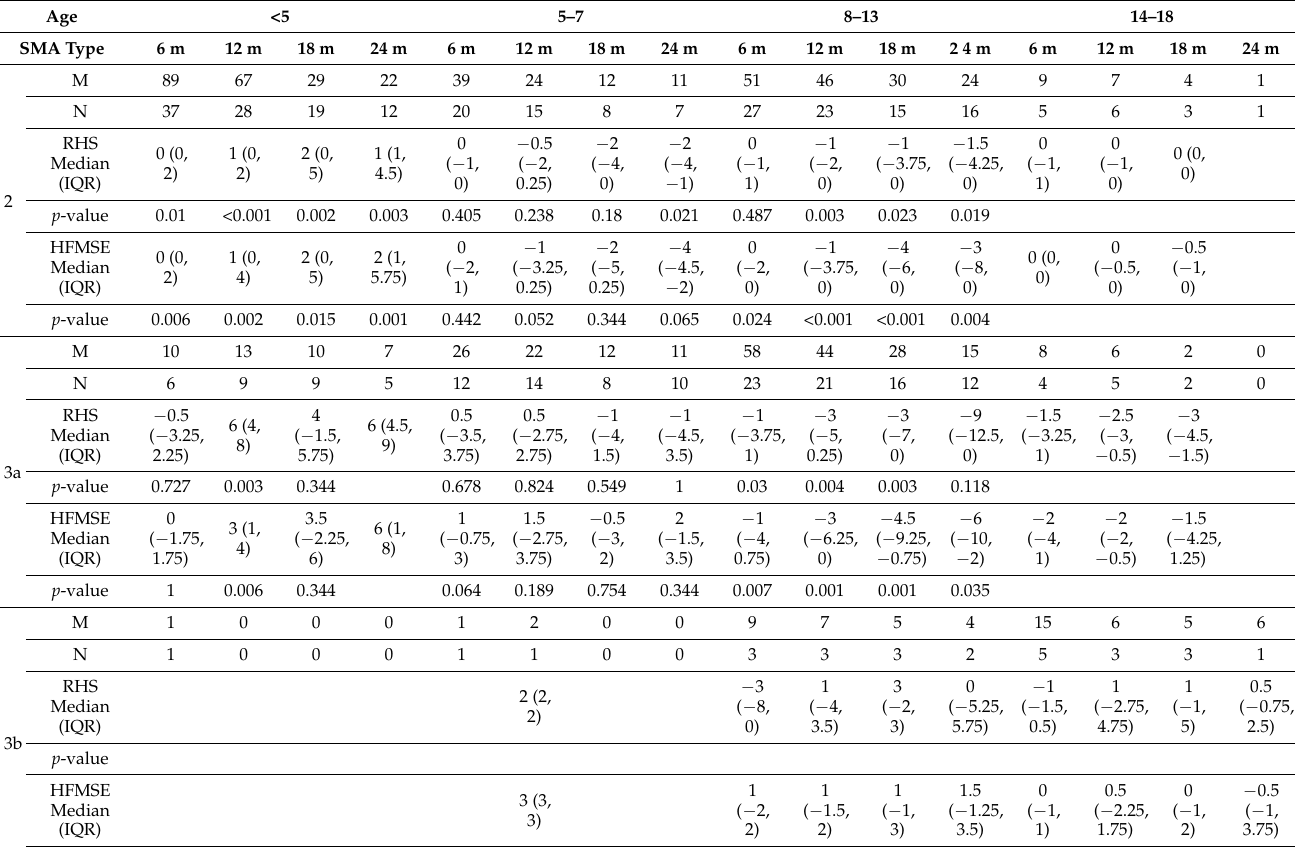
Table 3. Up to 2-year median change in the RHS and HFMSE cross-tabulated by SMA type and age. N : number of participants, M : number of assessments, IQR : inter-quartile